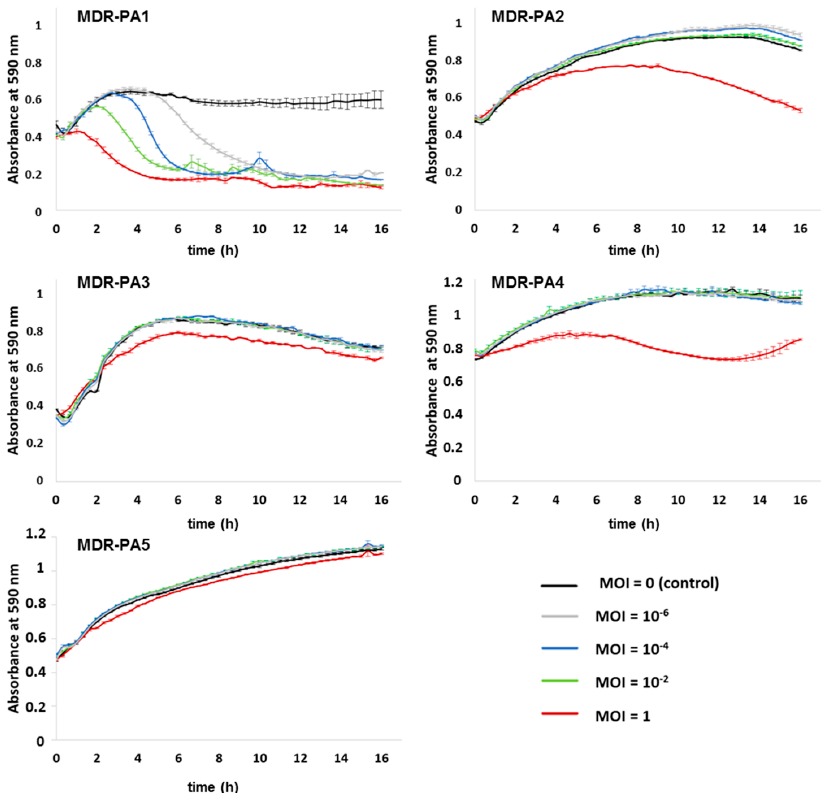
Figure 5. Activity of phage SL1 against planktonic cells of five different multi-drug resistant P. aeruginosa strains (MDR-PA1-5). Each experiment was performed in triplicate, and bars indicate standard deviation.